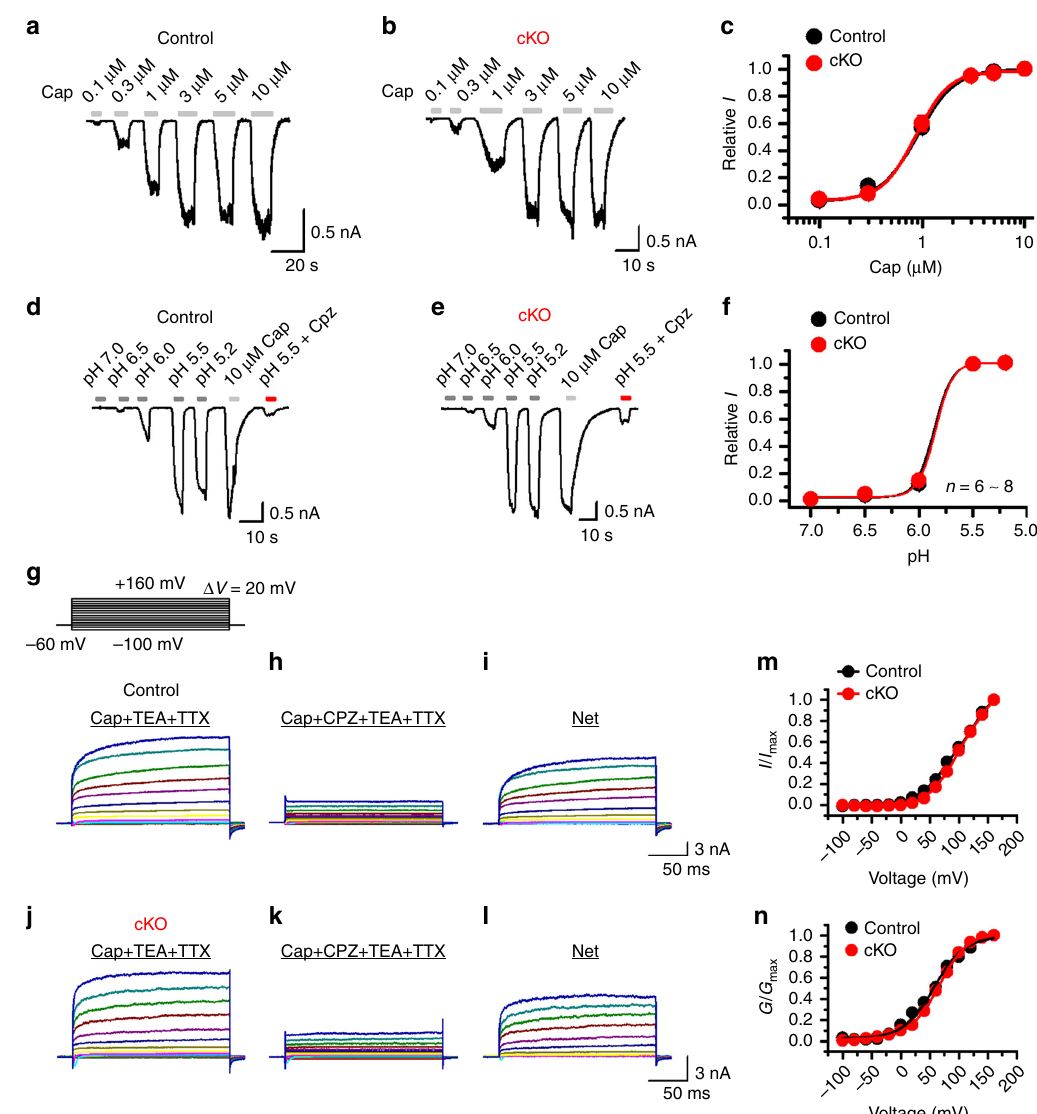
Fig. 8 SUMOylation had no effect on capsaicin- and proton-evoked and the voltage dependence of TRPV1 channel activation in DRG neurons. a , b Representative whole-cell currents at − 60 mV evoked by varying concentrations of capsaicin (Cap) as indicated in DRG neurons isolated from control ( a ) and SENP1 cKO mice, respectively. Holding potentials = − 60 mV. c Concentration responses to capsaicin for control and SENP1 cKO DRG neurons. Data were fi tted with Hill equation, which yielded: control, EC 50 = 0.91 ± 0.01 μ M, and n H = 2.40± 0.15 ( n = 8); SENP1 cKO, EC 50 = 0.87 ± 0.02 μ M and n H = 2.68 ± 0.28 ( n = 10). d , e Representative whole-cell currents at − 60 mV in responses to bath solutions of varying pH as indicated in control and SENP1 cKO DRG neurons, respectively. The cell was also stimulated with 10 μ M Cap and then pH 5.5 combined with 10 μ M capsazepine (Cpz) to con fi rm that the currents were mediated by TRPV1. f Dose responses to pH for control and SENP1 cKO TRPV1-positive DRG neurons. Data were fi tted with Hill equation, which yielded: control, pH 0.5 = 5.9 ± 0.1, n H = 5.3 ± 2.4 ( n = 8); SENP1 cKO, pH 0.5 = 5.8 ± 0.1, n H = 5.6 ± 3.2 ( n = 7). g – l Representative whole-cell currents elicited by the voltage step protocol shown in the inset in g for control ( g – i ) and SENP1 cKO ( j – l ) DRG neurons. The cell was exposed to 0.3 μ M Cap combined with 10 mM TEA-Cl and 1 μ M TTX ( g and j ) or 0.3 μ M Cap combined with 10 mM TEA-Cl, 1 μ M TTX, and 10 μ M Cpz ( h and k ), in order to isolate the net TRPV1-mediated currents through subtraction ( i and l ). I – V ( m ) and G – V ( n ) relationships of TRPV1 for control and SENP1 cKO DRG neurons. Data in n were fi tted with Boltzmann equation, which yielded: control V 1/2 = 56.9 ± 2.6 mV, and slope factor = 26.2 ± 2.3; SENP1 cKO, V 1/2 = 65.4 ± 1.1 mV, and slope factor = 25.2 ± 1.0